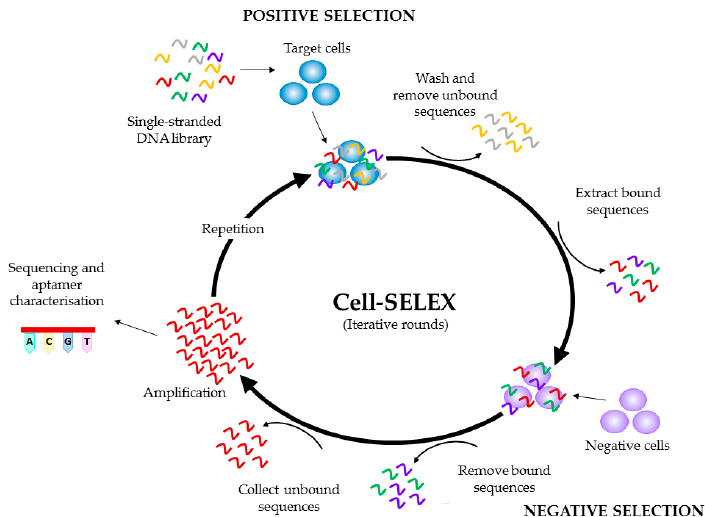
Figure 3. Schematic representation of a Cell-SELEX (systematic evolution of ligands by exponential enrichment) protocol. Initially, a single-stranded DNA library is incubated with the target cells. The cells are washed to remove the unbound sequences, and the bound sequences are collected, prior to incubation with negative (control) cells. The bound sequences are removed and discarded, whilst the unbound sequences are amplified and used to begin the next round of SELEX. This cycle is repeated a number of times, before the pool is sequenced and characterised. The bold arrows denote one iterative round of SELEX, with the small arrows depicting the different steps of the protocol: incubation of the single-stranded DNA library with the target cells; washing and removal of the unbound sequences, incubation with negative cells; removal of bound sequences; collection of bound sequences; amplification and cycle repetition prior to sequencing and aptamer characterization.